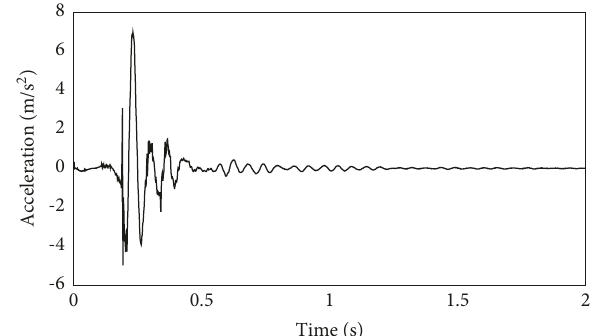
Figure 3: Acceleration-time response of the floor to the heel-drop